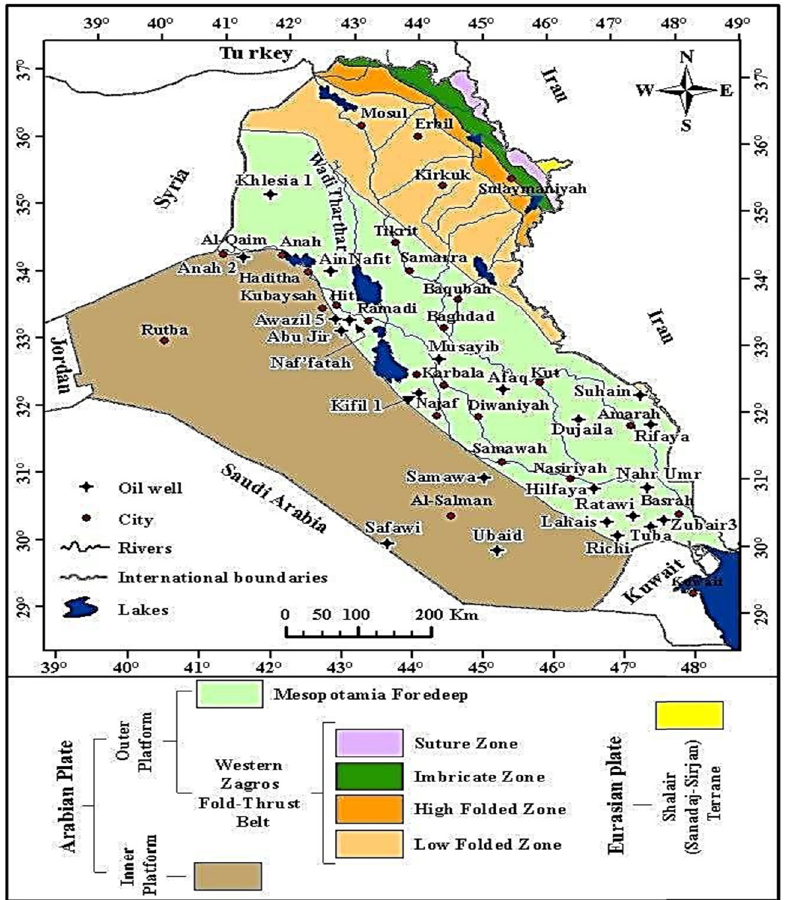
Figure 4: Tectonic map of Iraq.